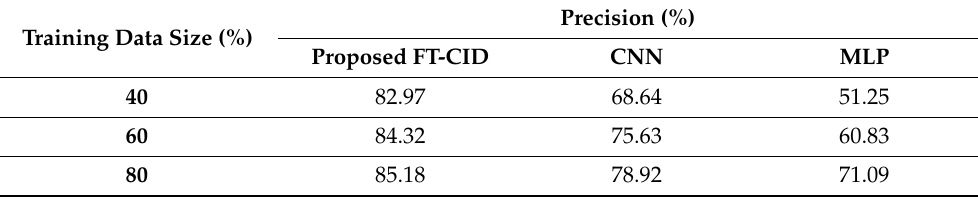
Figure 4. Precision performance for FT-CID, CNN, and MLP. Table 1. Comparative experimental precision results.